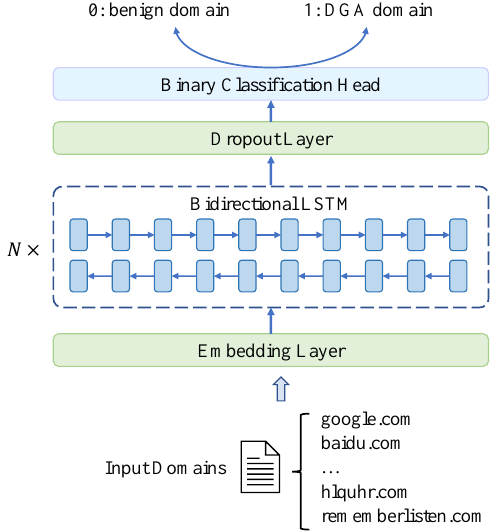
Figure 2. Overview of DGA Detector based on